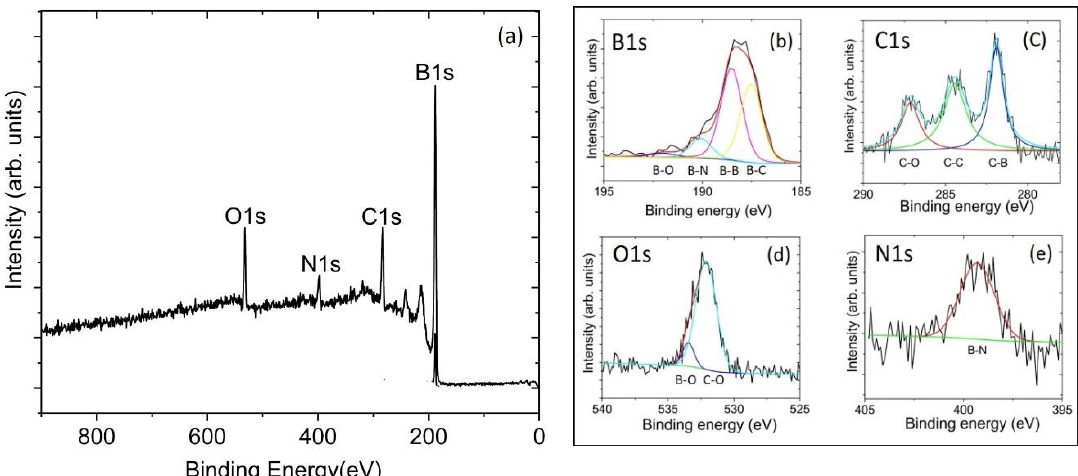
Figure 2. X-ray photoelectron spectroscopy survey scans of ( a ) the BC-1 coating with an elemental composition of 88.1% B, 8.7% C, and 3.2% O. Panels ( b ), ( c ), and ( d ) show high-resolution scans for B1s, C1s, and O1s, respectively, with corresponding peaks assigned to B-C, B-B, and C-C (adventitious carbon) bonding. Sample BC-1 also shows bonding associated with C-O.